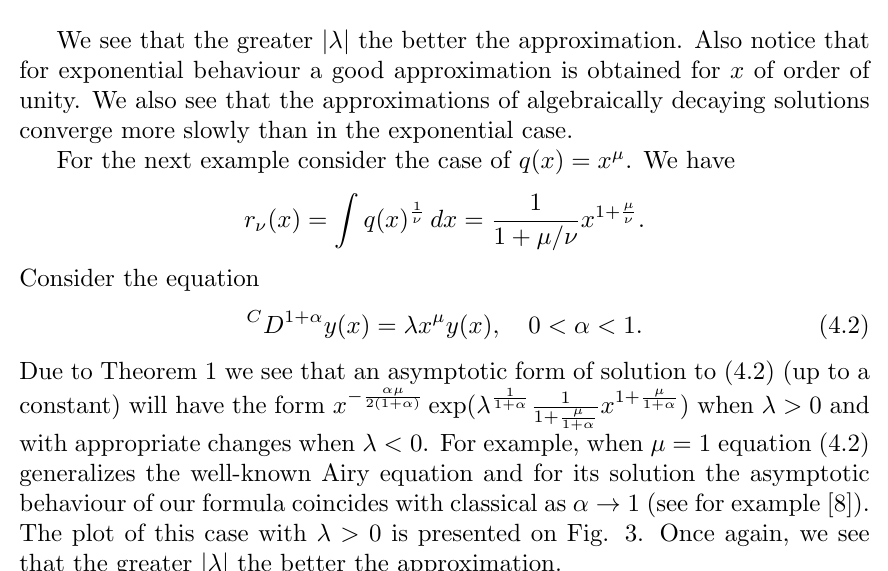
Figure 2. Plots of y exact /y asym as in (4.1) for C = y (0), α = 0 . 8, λ = 0 . 5 (dot-dash) a) 1 (dash) and 2 (solid line), b) − 1 (dash) and − 2 (solid line)